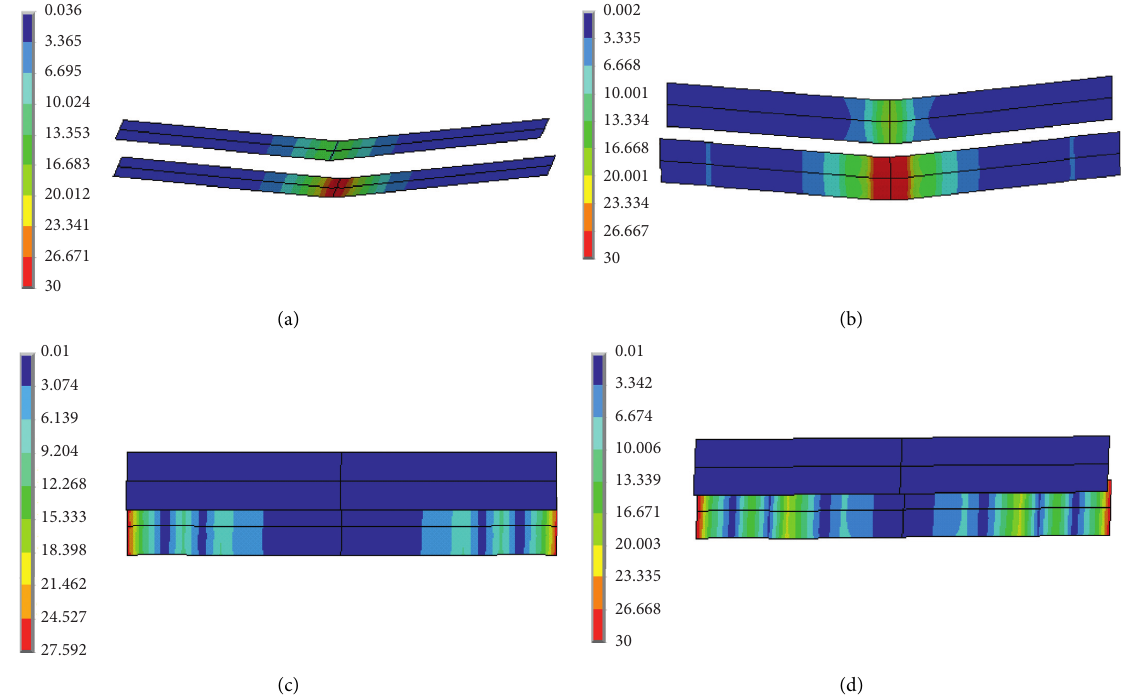
Figure 30: The stress distribution of steel plates when the stud spacing is changed. (a) Stud spacing of 67.5 mm. (b) Stud spacing of 135 mm. (c) Stud spacing of 270 mm. (d) Stud spacing of 405